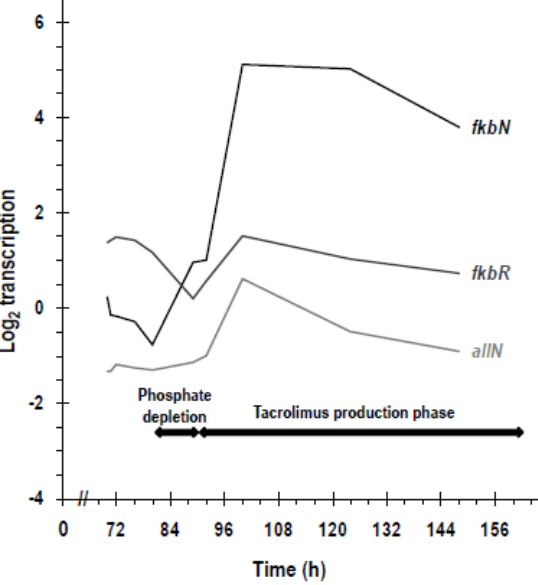
Figure 4. Transcriptional profiles of genes encoding transcriptional regulators of the fkb cluster. Transcription of fkbN , fkbR and allN in S. tsukubaensis NRRL 18488 grown in MGm-2.5 production media. As indicated in the graph, phosphate depletion occurs between 80 h and 89 h and tacrolimus is detected from 89 h. The cultures were performed in duplicated flasks. Error bars have been omitted to facilitate the visualization of the results.